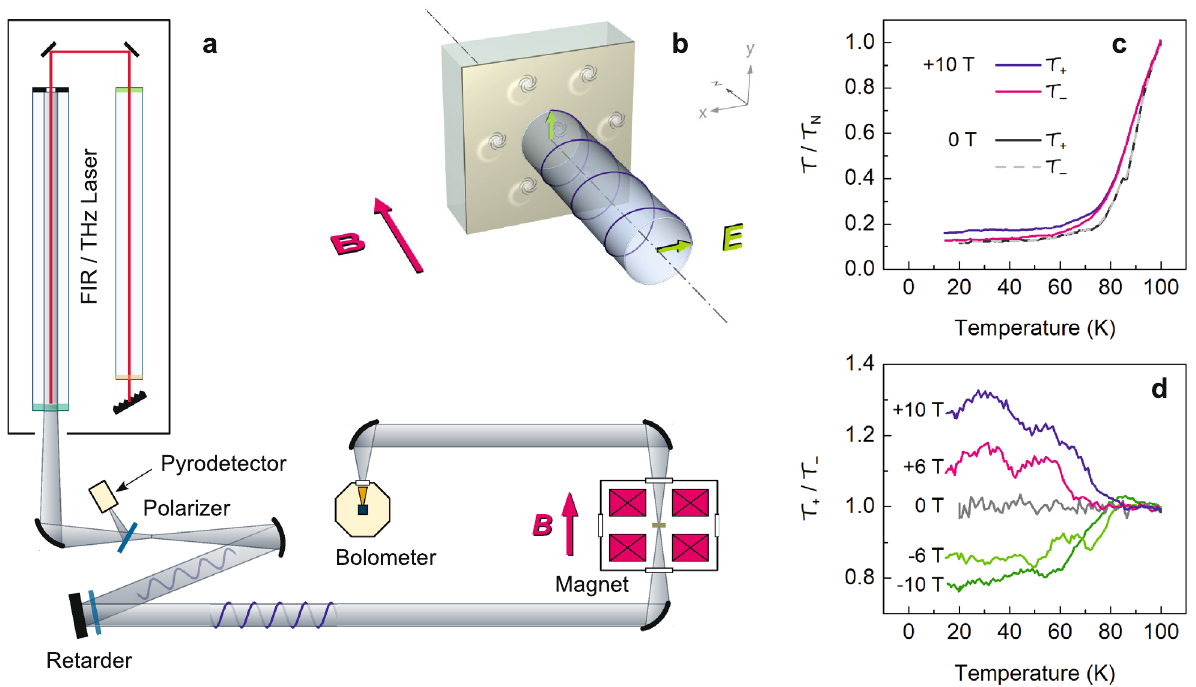
Figure 1. Far-infrared measurement of fluxon mass. ( a ) Sketch of the magneto-optical setup. The continuous laser beam is split by a linear wire-grid polarizer; the reflected part is monitored using a pyroelectric detector to keep trace of unavoidable power fluctuations, whereas the transmitted part proceeds toward the sample. The retarder converts the light from linear to circular polarization. The propagation of the circularly polarized beam and the magnetic field are perpendicular to the film surface, as detailed in panel ( b ). ( b ) Vortices in the film (gray circles) control the transmittance of the sample via the following mechanism: The electric field of the laser light drives the supercurrent. The Magnus force accelerates vortices in the direction perpendicular to the supercurrent; in reaction, the vortex motion affects the supercurrent and, thus, the transmittance. In the sketch, the electric field in the sample, as well as the vortices, rotate clockwise. If the light frequency is close to the cyclotron frequency of vortices, the motion of vortices is resonantly enhanced, leading to the